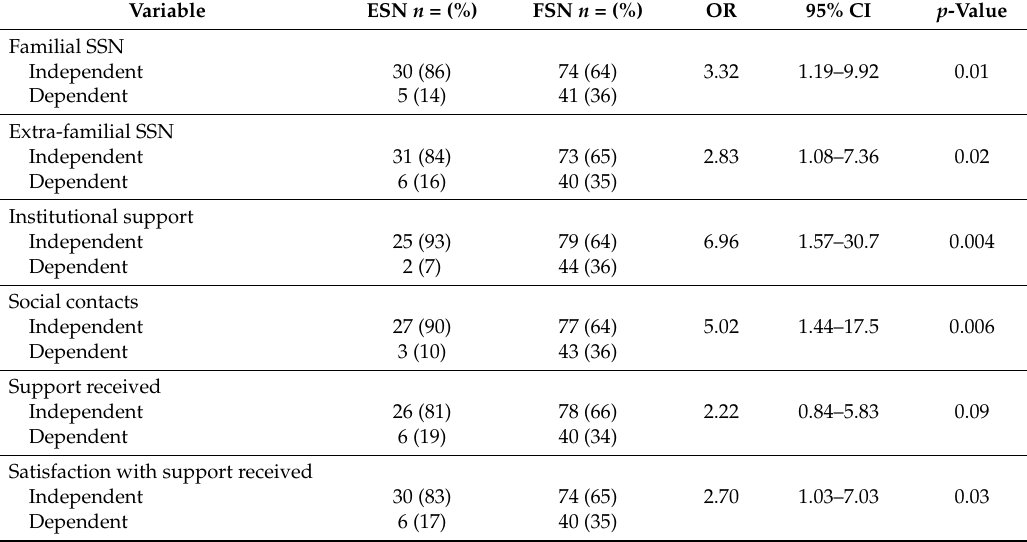
Social support networks as a risk factor for instrumental activities of daily living (IADL)